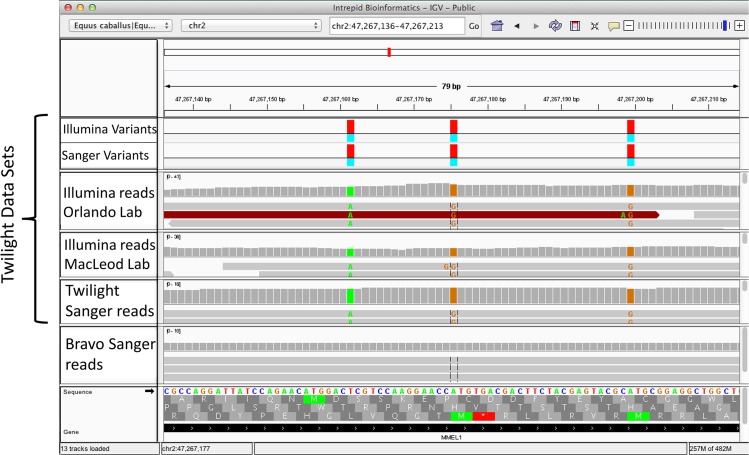
Twilight discrepancies resolved by Bravo data.An example of a region showing homozygous differences between Twilight and the reference which are resolved by alleles from Bravo. Region may be viewed in IGV at http://dx.doi.org/10.13013/J63X84K9. Link will download a JNLP file that will webstart IGV, centered on region of interest. Bases within the reads that agree with the reference are not rendered.